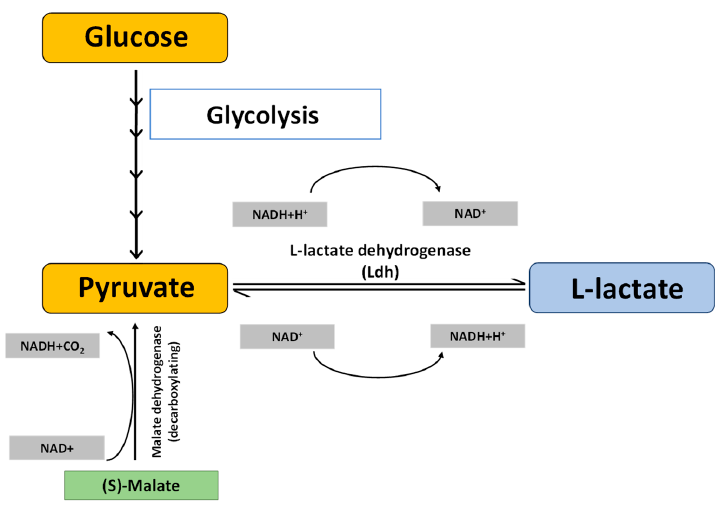
Figure 1. Schematic representation of L-lactate metabolism: Pyruvate, the end-product of glycoly- sis, is converted to L-lactate by the L-lactate dehydrogenase (Ldh) enzyme. This reversible reaction converts NAD + to NADH+H + and vice versa. Pyruvate is also formed by the decarboxylation of (S)-Malate, catalysed by the Malate dehydrogenase (Maldh) (decarboxylating) enzyme with the concomitant release of NADH and CO 2 , which is then converted to L-lactate by the Ldh enzyme. Arabidopsis Ldh1 is to date the only plant Ldh enzyme reported to be expressed